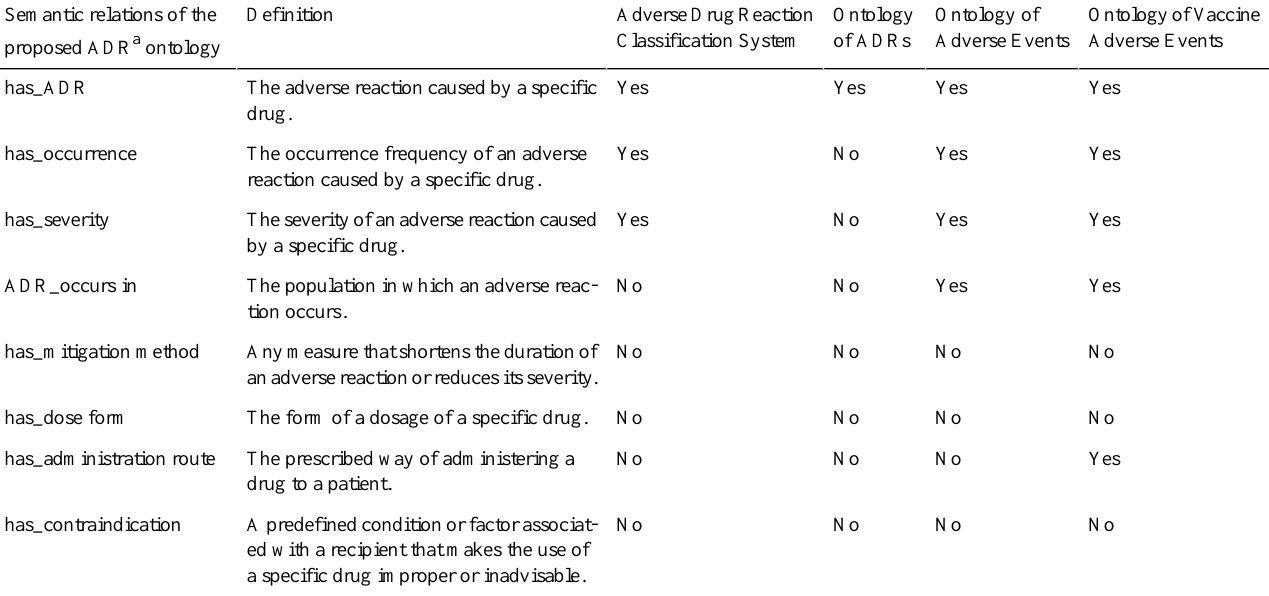
Table 1. Comparison with existing